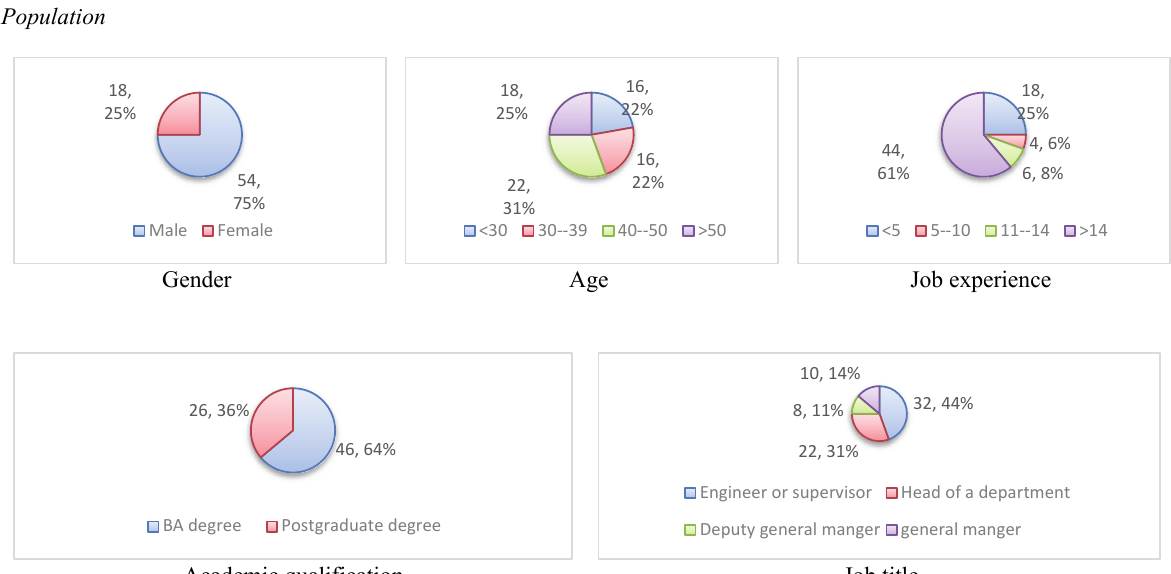
Fig. 1. Characteristics of the study’s